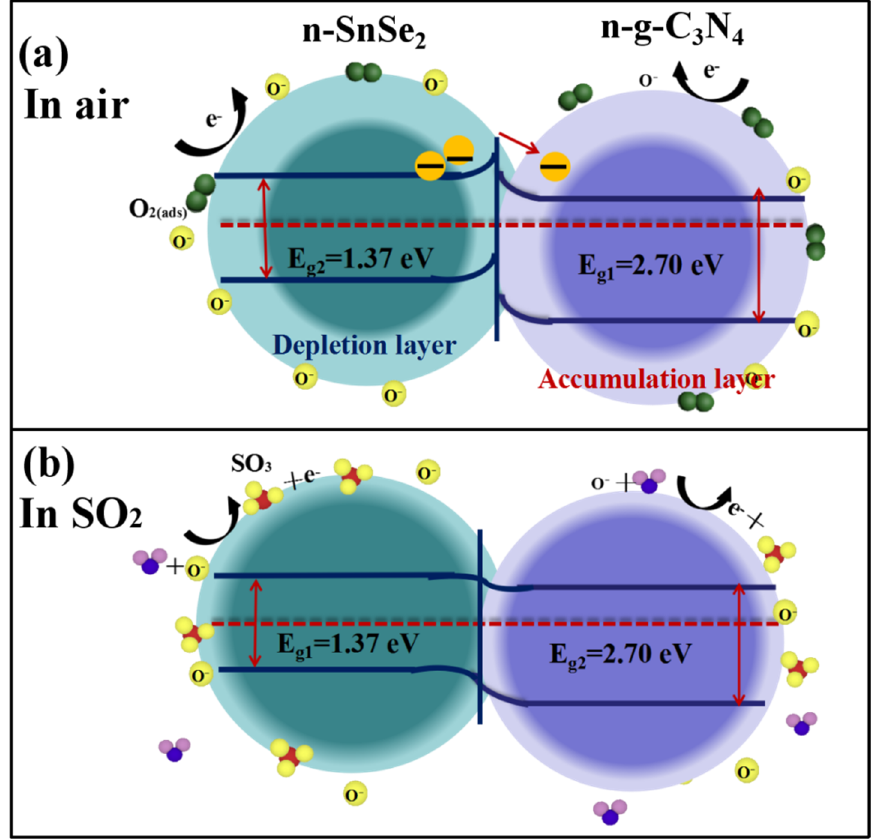
Figure 8. Schematic diagram of microscopic sensing mechanism of g-C 3 N 4 /SnSe 2 composite sensor.